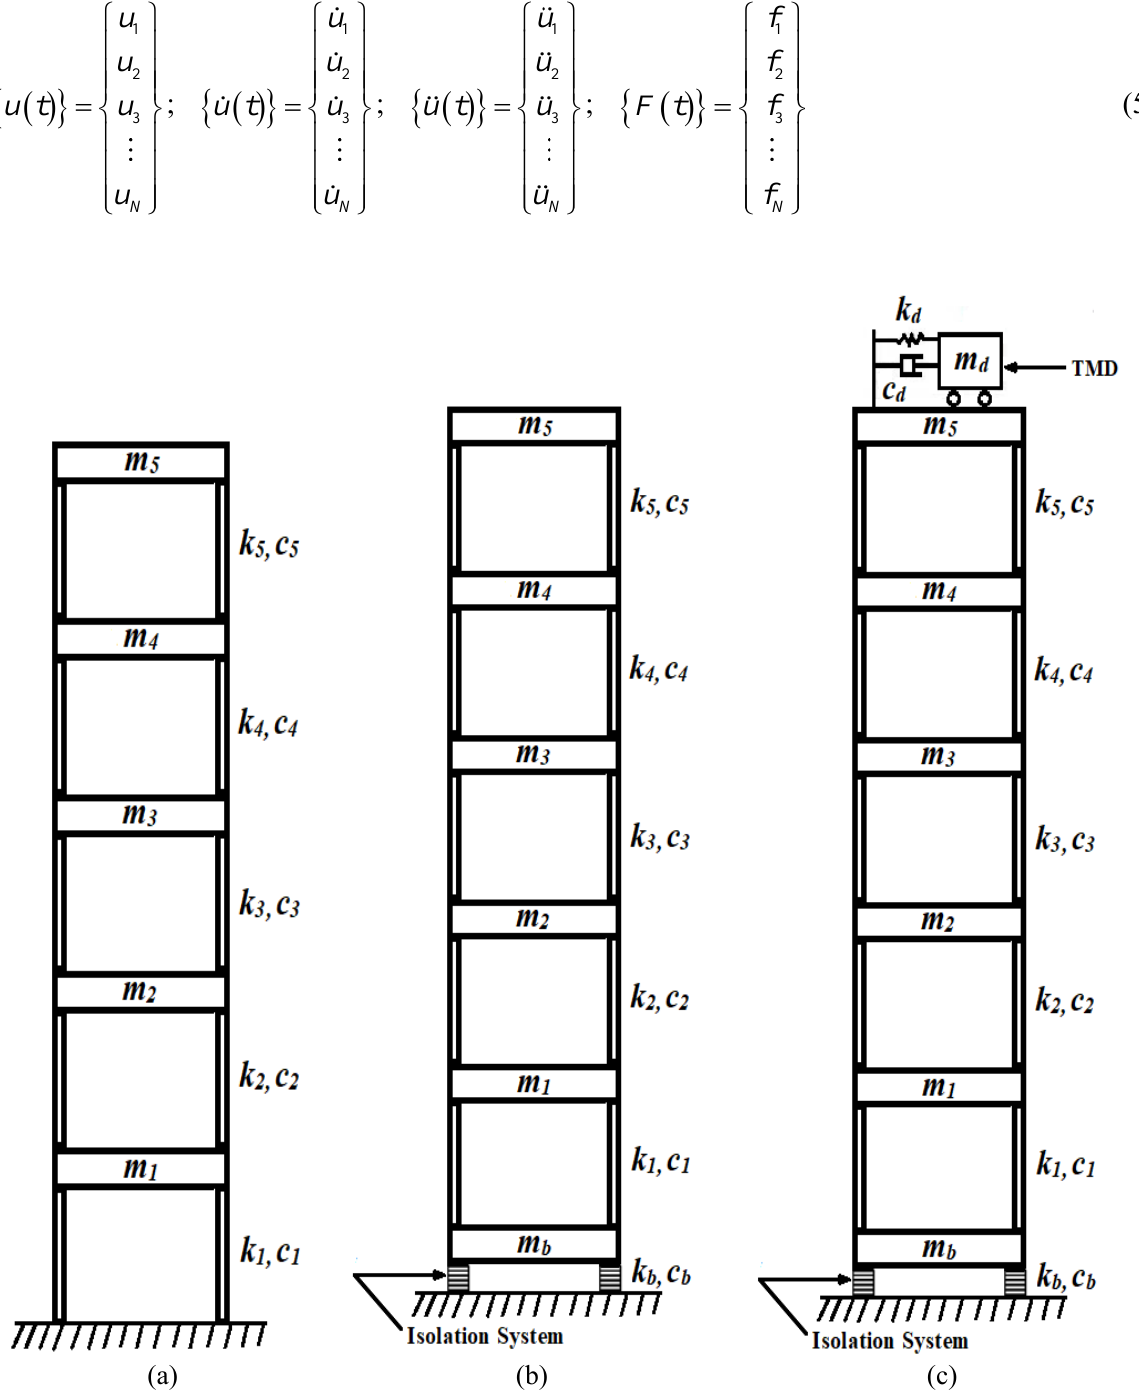
Fig. 2. Five storey shear building model (a) Fixed base (b) Supported on isolation system (c) Supported on isolation system with tuned mass damper at